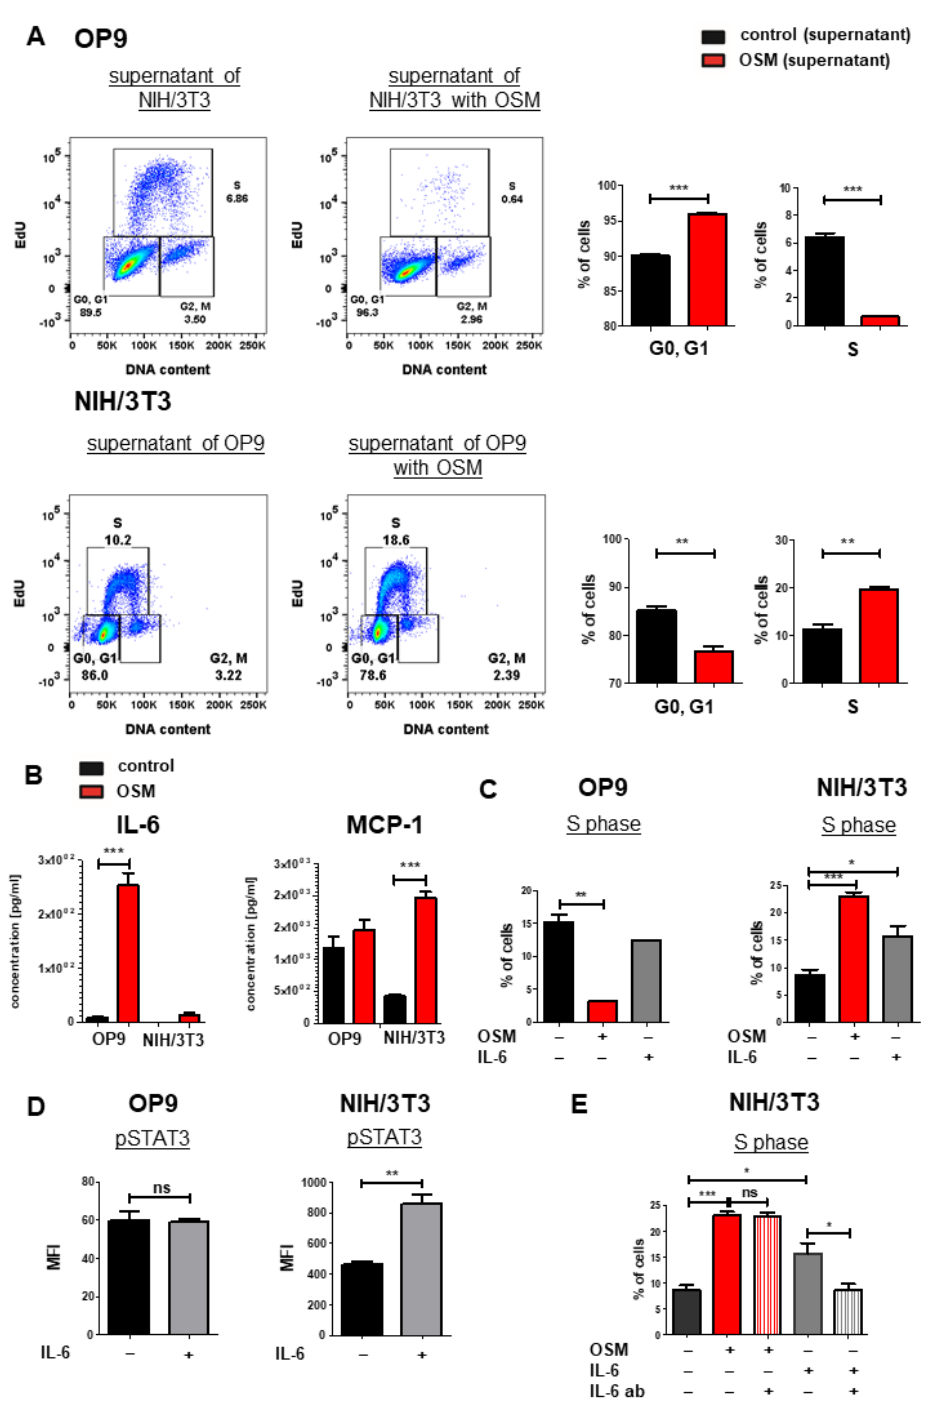
Figure 6. IL-6 has synergistic effects to OSM on the proliferation of NIH/3T3 cells. ( A ) Representative FACS plot (left) and quantification of cell cycle phases (right) of OP9 and NIH/3T3 cells with supernatant from the other respective cell line. Cells were treated with 10 ng/mL mOSM. Student’s unpaired t -test. ** p < 0.01, and *** p < 0.001. ( B ) Cytokine secretion of OP9 and NIH/3T3 cells (+/- mOSM treatment) was measured using a bead-based array detecting 13 cytokines. Student’s unpaired t -test *** p < 0.001. ( C ) Quantification of the S phase for OP9 and NIH/3T3 untreated or treated with 10 ng/mL mOSM or mIL-6. Student’s unpaired t -test. * p < 0.05, ** p < 0.01, and *** p < 0.001. ( D ) Phospho-specific STAT3 flow cytometry analysis of OP9 and NIH/3T3 cells +/ − 10 ng/mL IL-6. ** p < 0.01. ns = not significant. ( E ) Quantification of S phase for NIH/3T3 cells treated with 10 ng/mL mOSM +/ − IL-6-ab or 10 ng/mL mIL-6 +/ − IL-6 ab. One-way ANOVA and Bonferroni post-test. * p < 0.05 and *** p < 0.001. ns = not